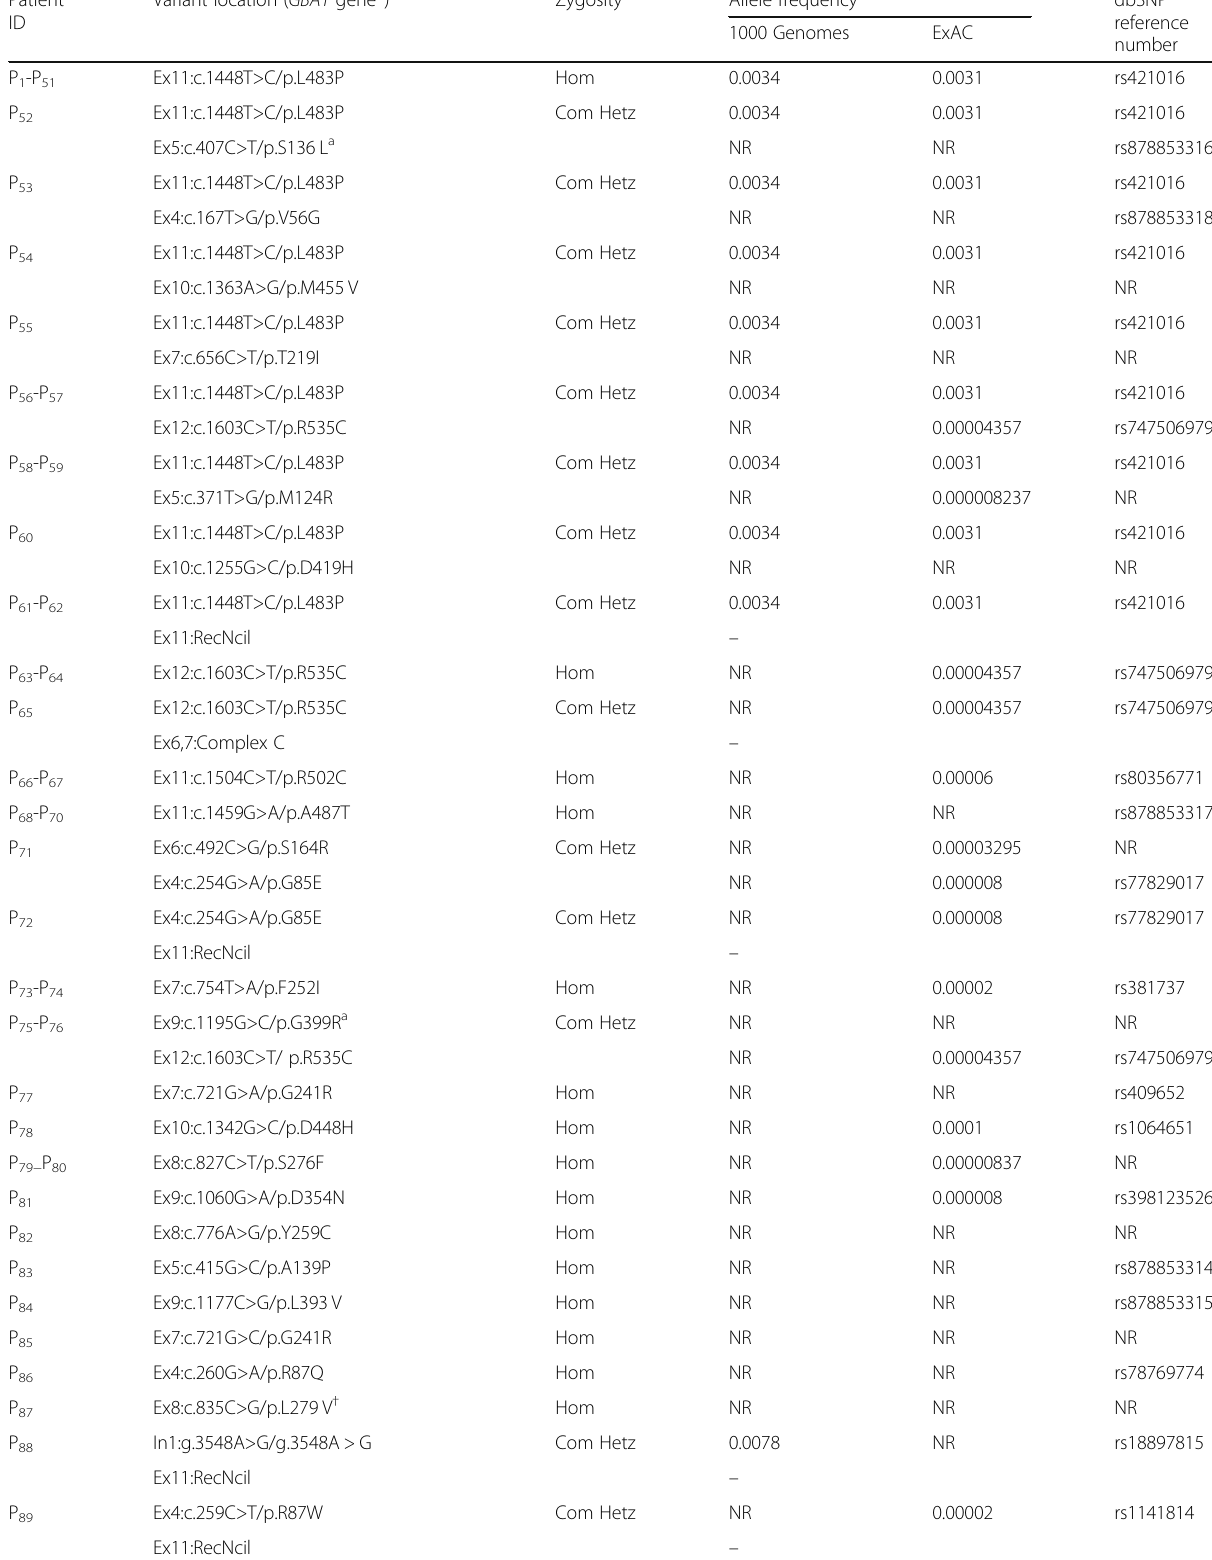
Table 2 Molecular analysis of the patients with Gaucher disease Patient